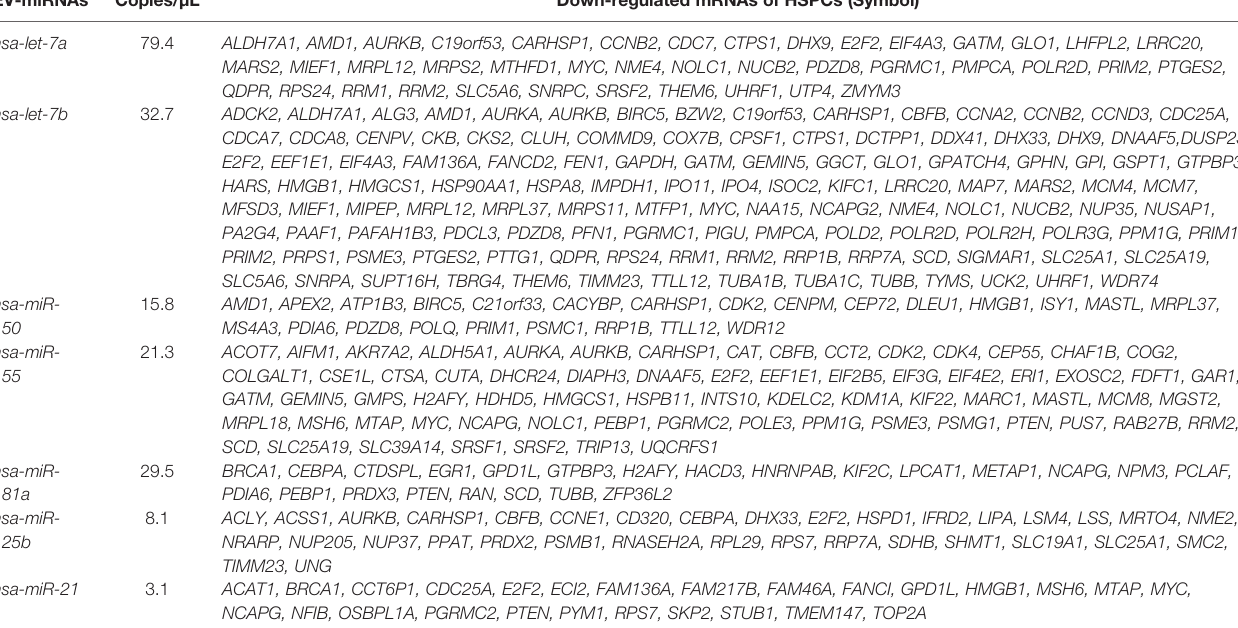
TABLE 3 | AML-EV miRNAs and their mRNA targets among the down-regulated genes in HSPCs treated with KG1-EVs. EV-miRNAs